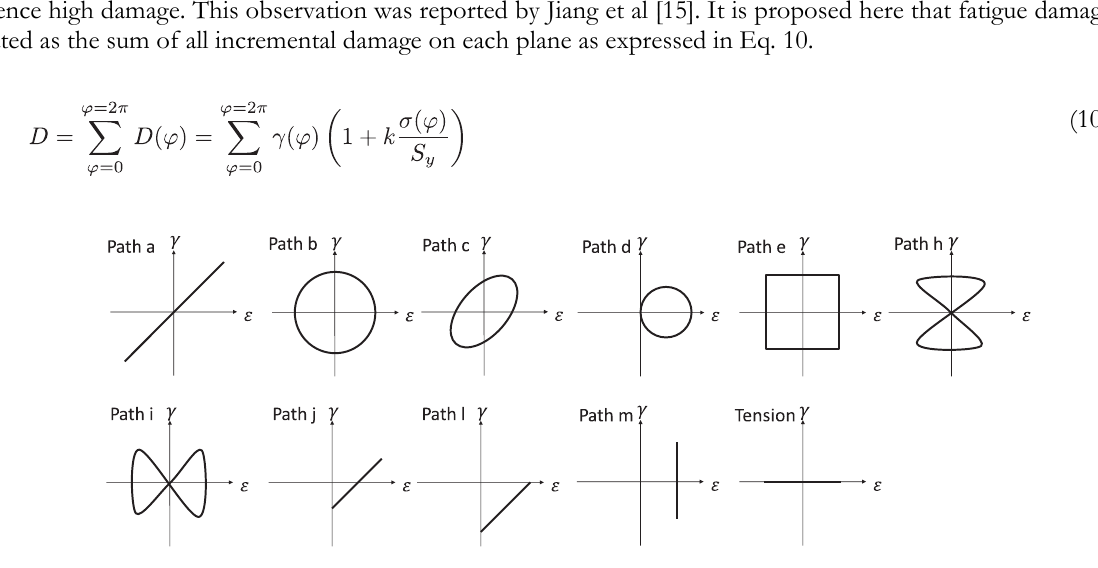
Figure 4: Parametric representation of Fatemi-Socie fatigue damage parameter for Nr20 and